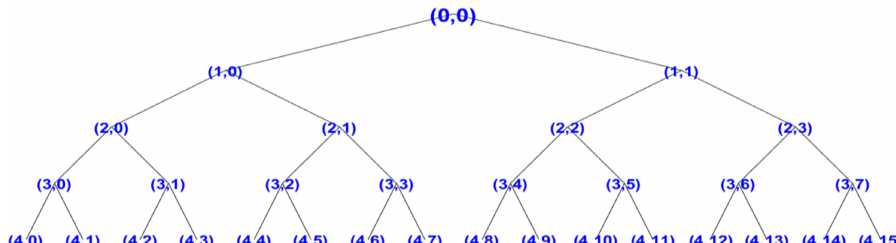
Figure 5. Four-layer wavelet packet decomposition